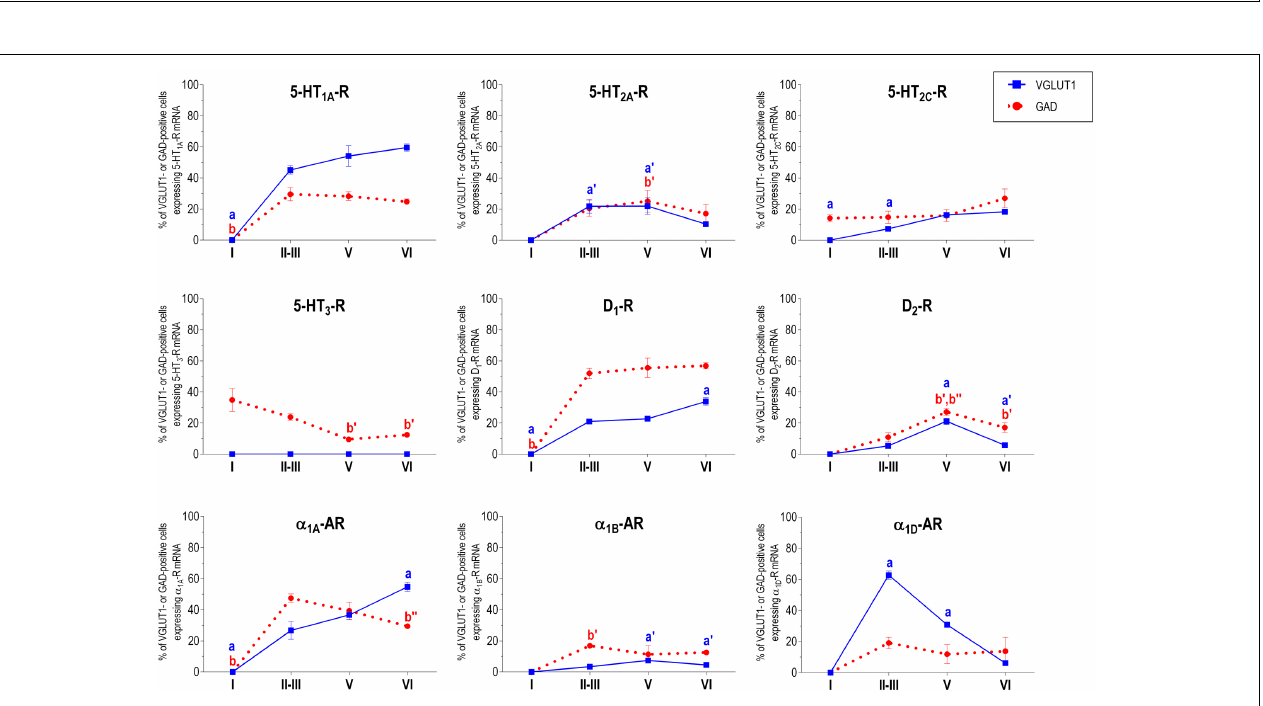
FIGURE 5 | Percentages of pyramidal (VGLUT1-positive) and GABA (GAD-positive) neurons expressing the nine monoamine receptors studied in the different layers of prelimbic area of medial prefrontal cortex. a p < 0.05 vs. rest of layers, a (cid:48) p < 0.05 vs. layer I; a (cid:48)(cid:48) p < 0.05 vs. layers II–III; a (cid:48)(cid:48)(cid:48) p < 0.05 vs. layer V (for VGLUT1 graphs). b p < 0.05 vs. rest of layers, b (cid:48) p < 0.05 vs. layer I; b (cid:48)(cid:48) p < 0.05 vs. layers II–III; b (cid:48)(cid:48)(cid:48) p < 0.05 vs. layer V (for GAD graphs), one-way ANOVA followed by Tukey’s test.